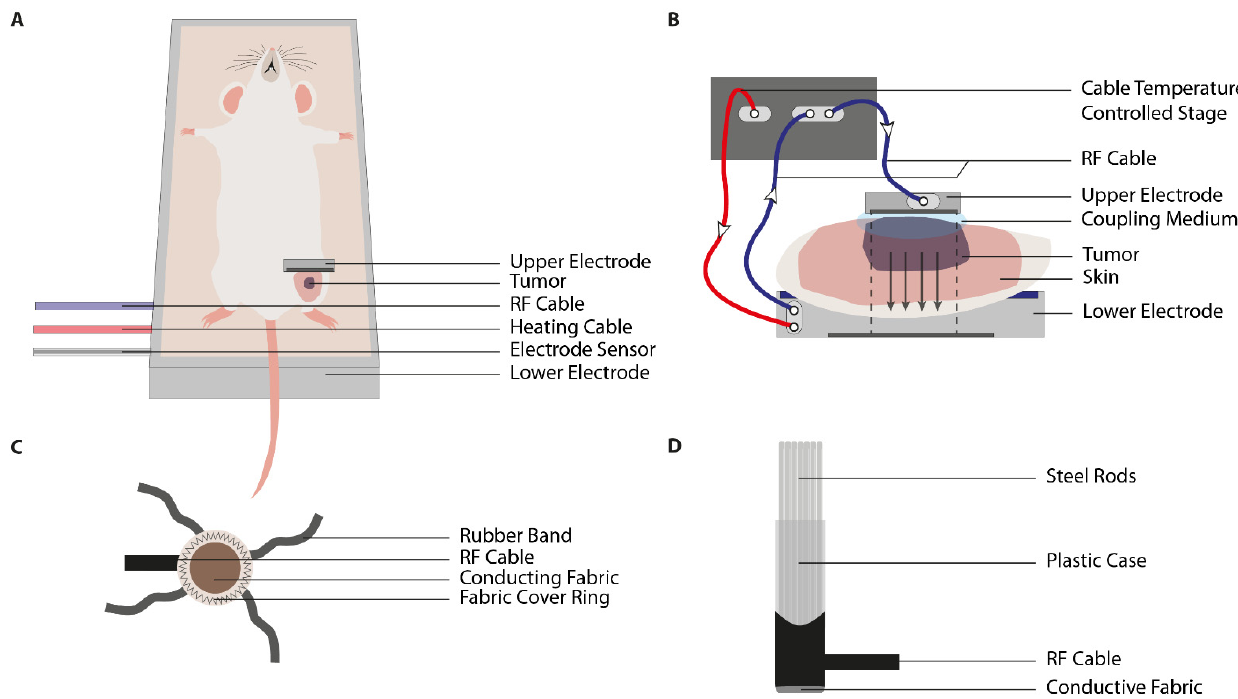
Figure 6. Illustrations of the capacitive hyperthermia device. ( A ) The positioning of the animal on the capacitive set up; ( B ) the lower and upper electrode should be placed plan-parallel for optimal heating. The upper electrode can either be a tissue electrode or a pole electrode; ( C ) the tissue electrode consists of a conducive fabric surrounded by a fabric cover ring. Placement of the tissue electrode is dependent on the use of rubber bands; ( D ) the pole electrode consists of multiple steel rods placed in a plastic casing. The bottom of the plastic casing is lined with a conductive fabric. Positioning of the pole electrode is facilitated by a height-adjustable arm. Figure 6 is adapted from Danics et al., Schvarcz et al., Vancsik et al., and Szasz et al. [141,142,144,155]. Table 5. Overview of the preclinical studies on application of local hyperthermia using capacitive hyperthermia sorted by year of publication and animal model.